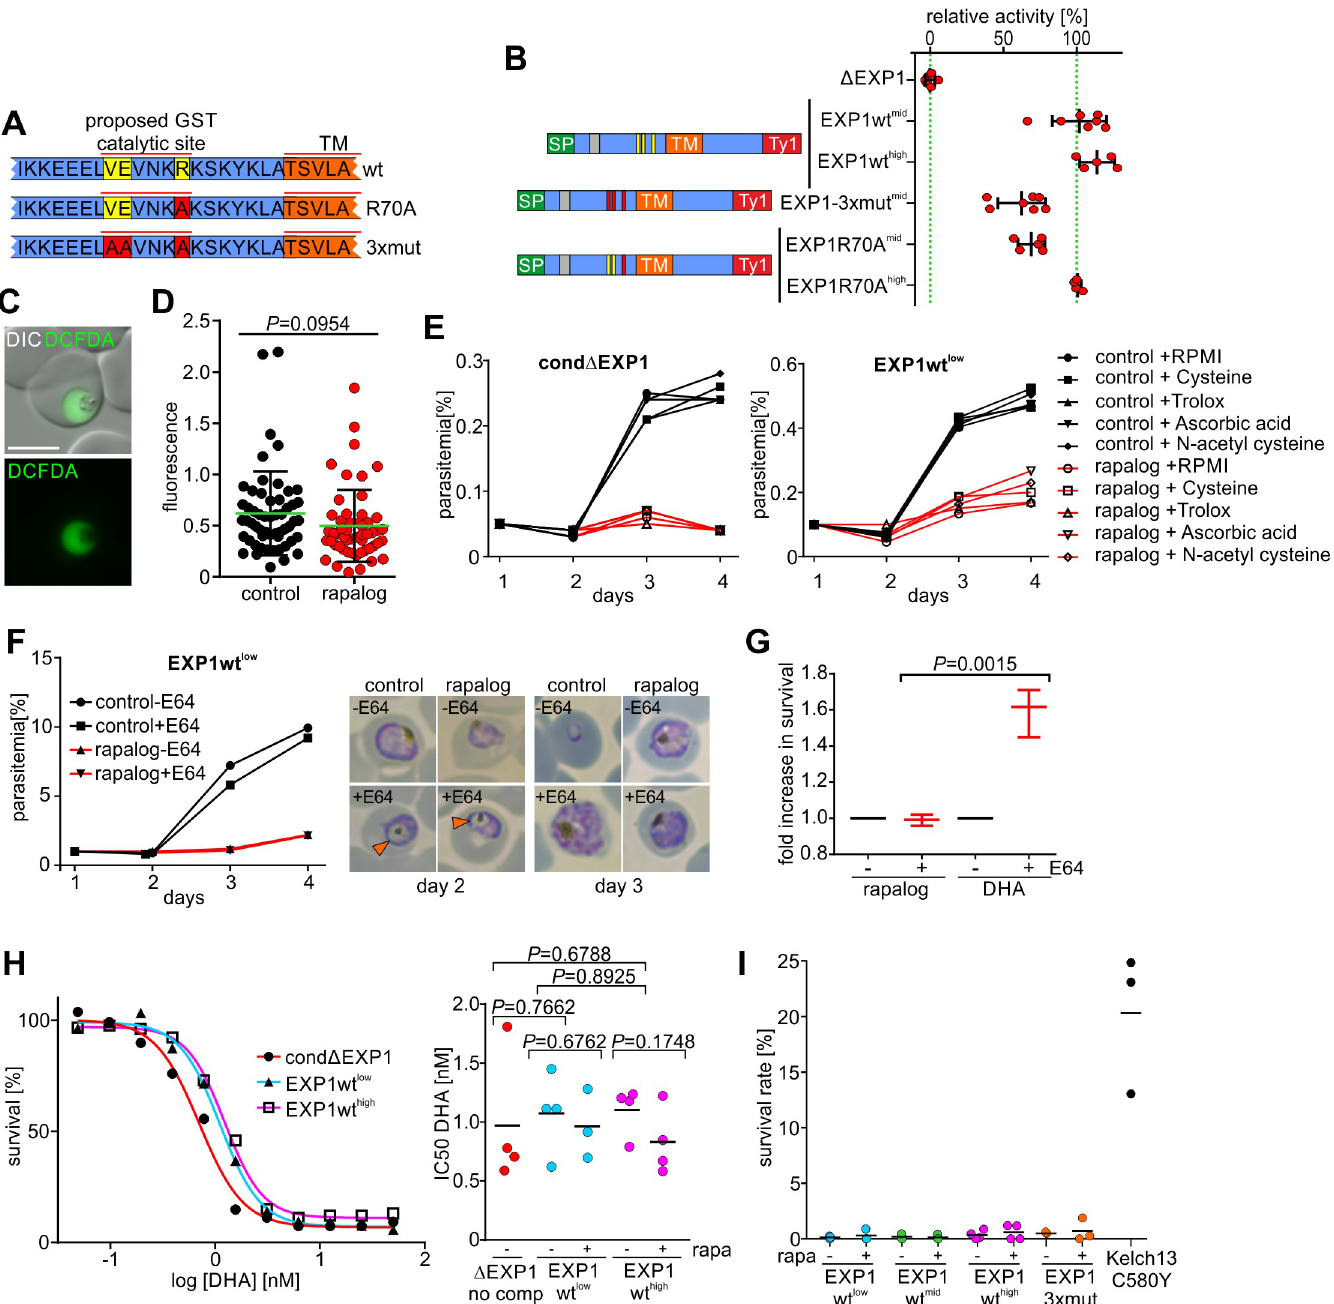
Fig 4. Dispensability of EXP1 GST activity and lack of oxidative stress in Δ EXP1 parasites. (A) Schematic of the region of EXP1 with the proposed catalytic site of the GST activity and of the mutations introduced. (B) Relative activity of the EXP1 complementation constructs indicated. Green lines: activity of EXP1wt ( nmd3 , mid) (set as 100%) and absence of activity ( Δ EXP1) set as 0%; n � 4 independent experiments per cell line. (C) Live cell images of cond Δ EXP1 parasites incubated with CM-H 2 DCFDA. Scale bars: 5 μ m. (D) Fluorescence intensity of matching stages of control and Δ EXP1 parasites (rapalog) incubated with CM-H 2 DCFDA (C). Results from 3 independent experiments with a total of n = 55 control and n = 53 Δ EXP1 cells. Green line, mean; error bars, SD. (E) FC growth curves of synchronous cond Δ EXP1 parasites and the complementation cell line EXP1 wt low after one cycle with (red) and without (black) rapalog (see Fig 1D) grown in RPMI alone or supplemented with the compounds indicated. One representative of n = 3 independent biological replicas. (F) Left, growth curves of EXP1wt low parasites ± E64 starting after one growth cycle ± rapalog (see Fig 1C). Right, Giemsa smears of parasites on day 2 (after incubation with E64) and day 3 (after removal). Arrowheads: swollen food vacuole. One representative of n = 3 biological replicas. (G) Effect of E64 treatment on survival of DHA and rapalog-treated EXP1wt low parasites versus untreated. Mean of n = 3 independent experiments. (H) Left, dose-response curves of the parasite lines indicated treated with DHA (0–50 nM). Right, DHA IC 50 values for these cell lines ± rapalog. Mean of n � 3 experiments. (I) RSAs of the indicated complementation cell lines and a Kelch13 C580Y mutant line. Data points are percent survival